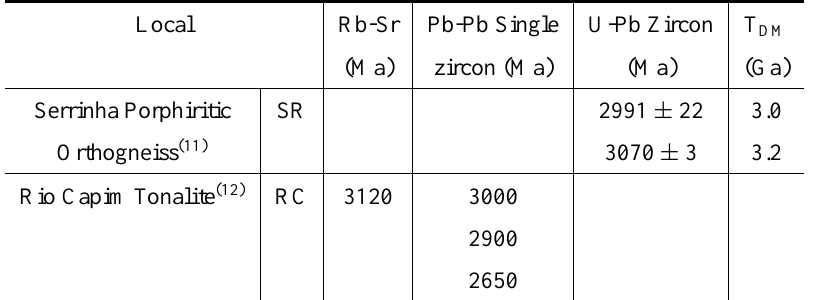
Serrinha Block. Ages of the Archean main plutonic rocks according to different radiometric methods. Gaal et al. (1987) (11), Oliveira et al.(1999) (12). WR = Whole